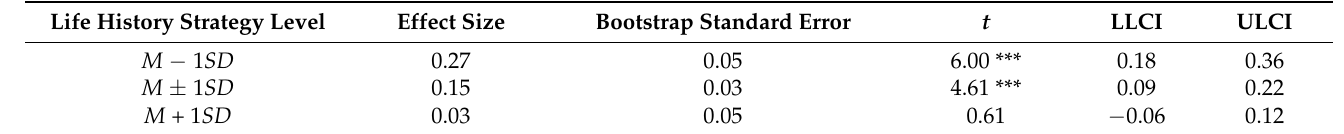
Table 4. The mediating effect of psychological capital under different life history strategy levels.